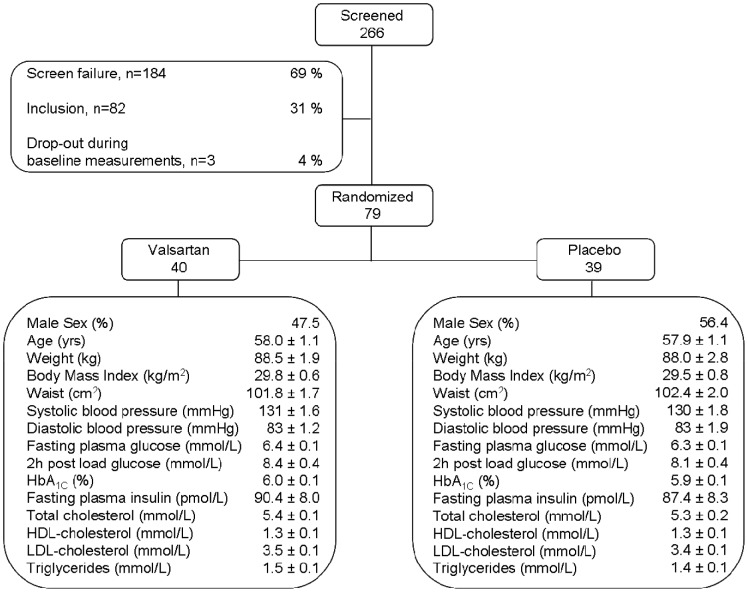
Enrollment flow chart.